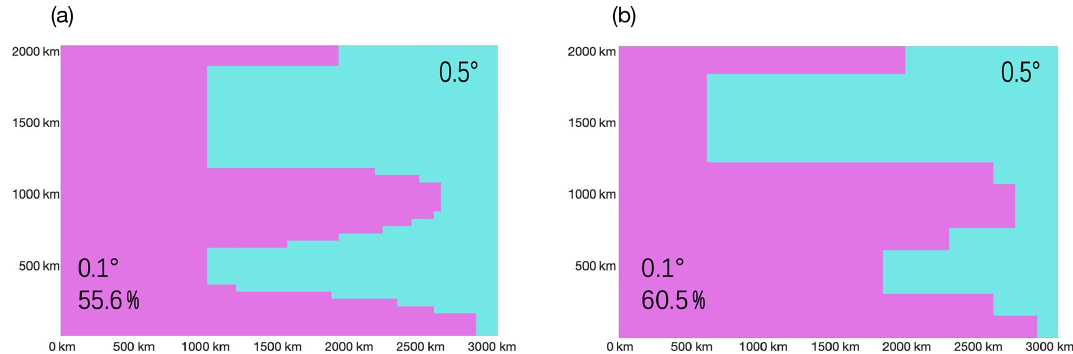
Figure 6. Two regional refinement settings from 0.5 to 0.1 ◦ of the double-gyre case. Panels (a) and (b) show L-M-I and L-M-II respectively. The background and the whole ocean basin are, by default, in 0.5 ◦ resolution and marked in cyan, and the region refined to 0.1 ◦ in each experiment is marked in purple.